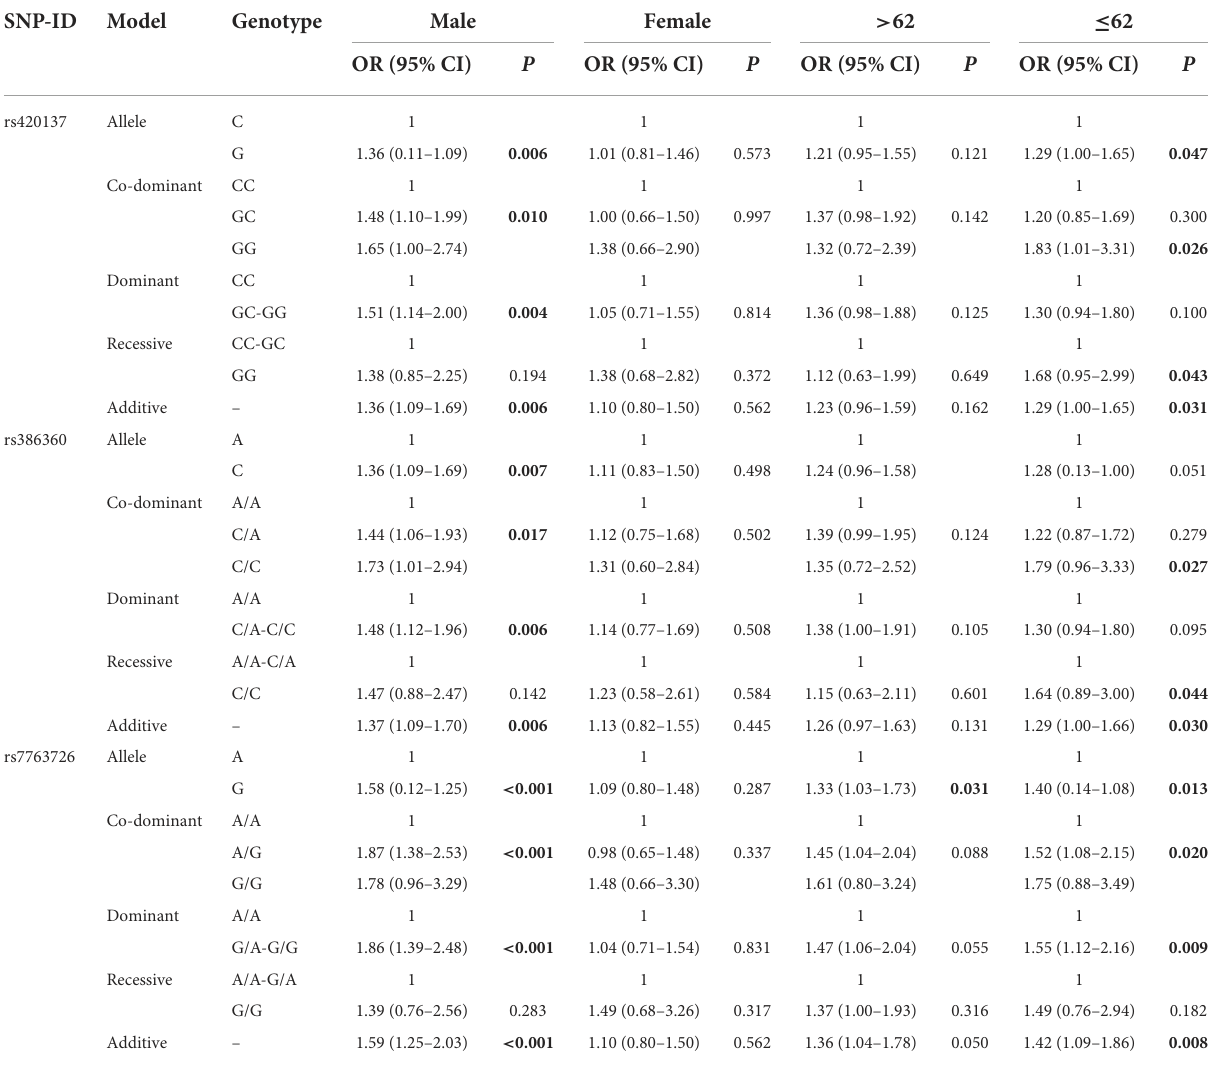
TABLE 4 FNDC1 SNPs associated with CHD risk stratified by gender and age